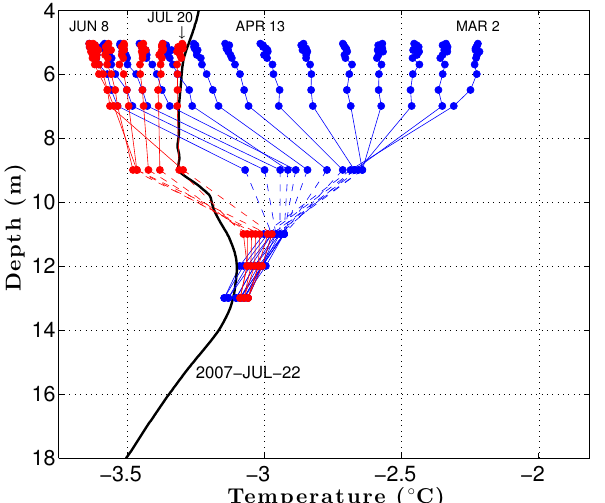
Earth Syst. Sci. Data